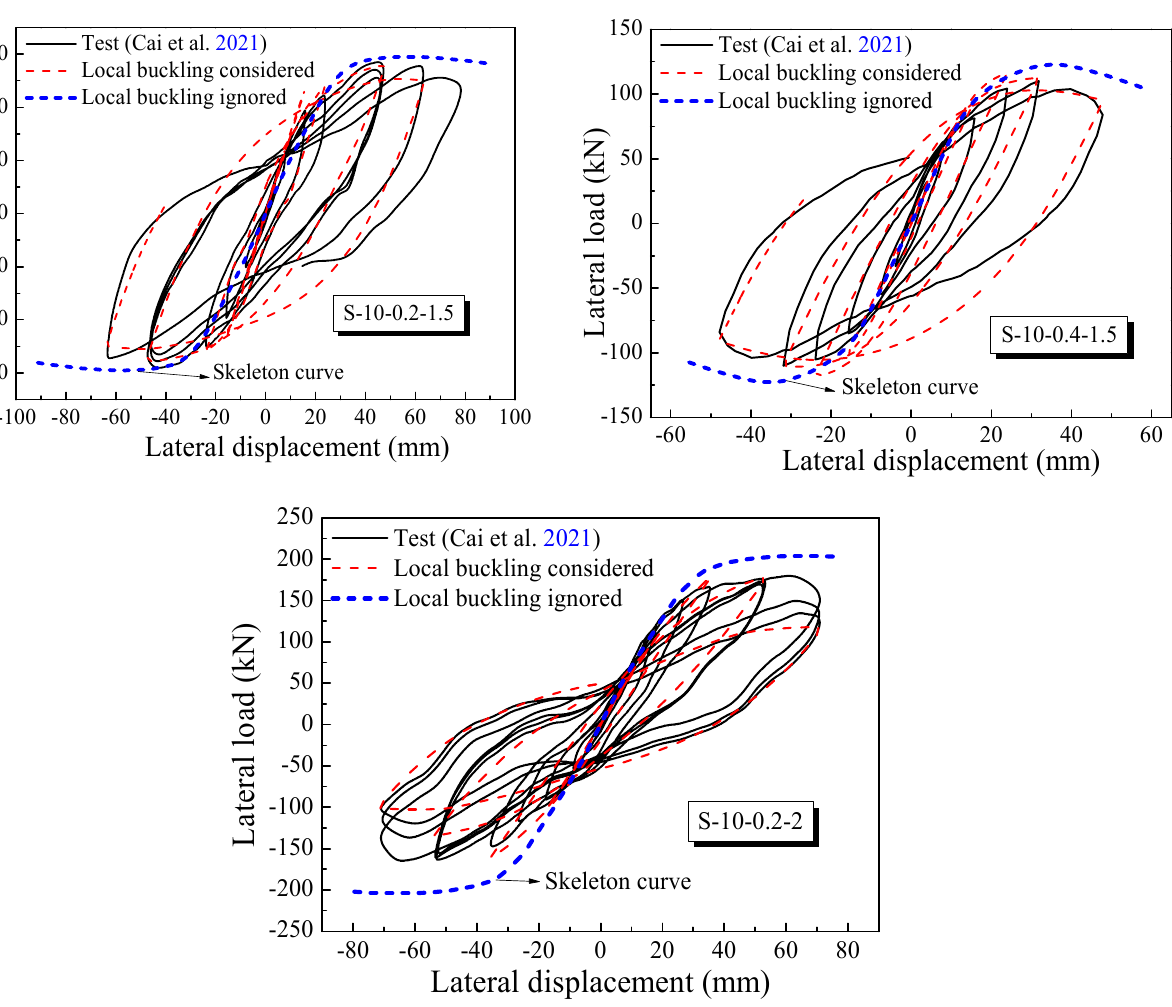
Figure 12. Calculations of the UHPFST specimens S-10-0.2-1.5, S-10-0.4-1.5 and S-10-0.2-2 [32]. The effective confinement effect of steel tubes on the core UHPC is the basis for UHPCFST members to fully exploit the potential of the two materials; therefore, the adverse effect of the local buckling of steel tubes should be reasonably considered in the seismic design, which is particularly